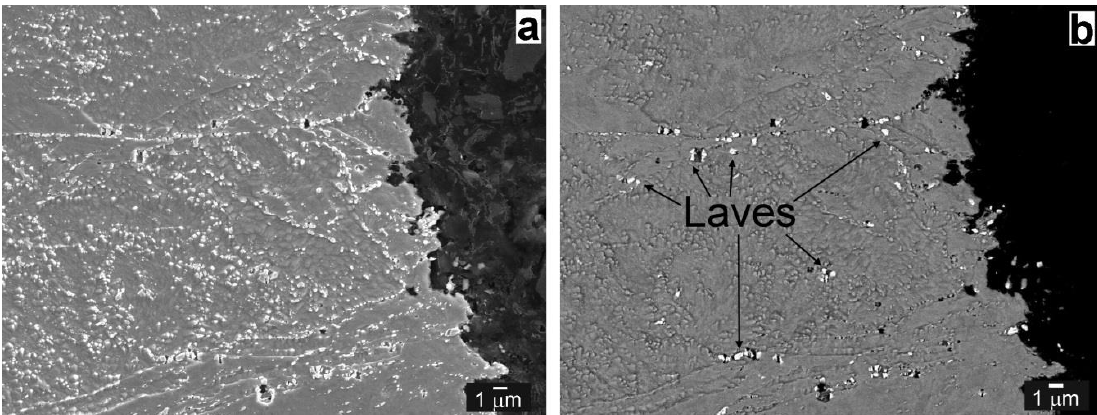
Figure 14. Microstructure and fracture path of the T92 BM region beneath the failure in the vicinity of T92 BM/Ni WM interface, state QT PWHT + 620 °C/2500 h + H: distribution of secondary phase particles in SE mode ( a ) and visualization of Laves phase particles in BSE mode ( b ).